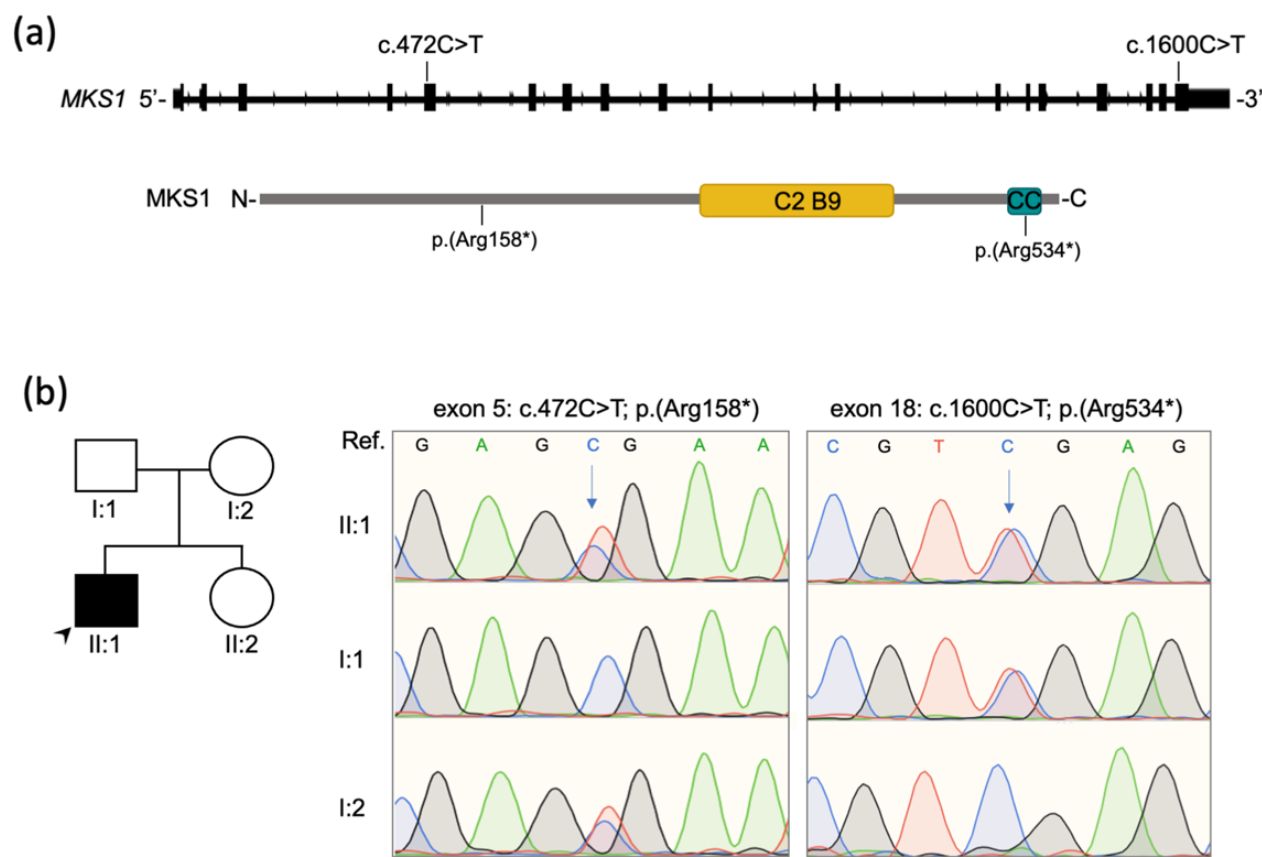
Figure 2. Biallelic pathogenic variants identified in MKS1 . ( a ) Schematics showing the MKS1 gene and protein with the relative position of the variants identified in the proband. The C2 B9-type domain (311-439 aa) and the coiled-coil domain (525-545 aa) of the MKS1 protein (UniProt Q9NXB0; 559 aa) are depicted (yellow and blue box, respectively). ( b ) Sanger sequencing traces indicate compound heterozygosity of the two variants in exon 5 and exon 18 in the patient (II:1) and heterozygosity in the unaffected parents (I:1, I:2). The arrows indicate the altered nucleotides. Arrowhead indicates the proband in the pedigree (II:1). Ref; Reference sequence.